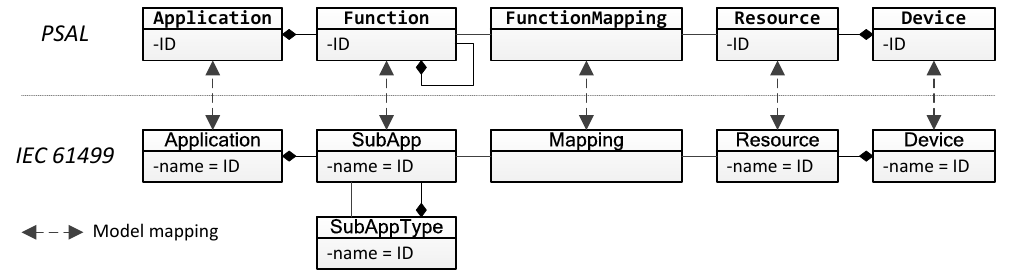
Figure 6. Mapping between IEC 61499 and PSAL for the component